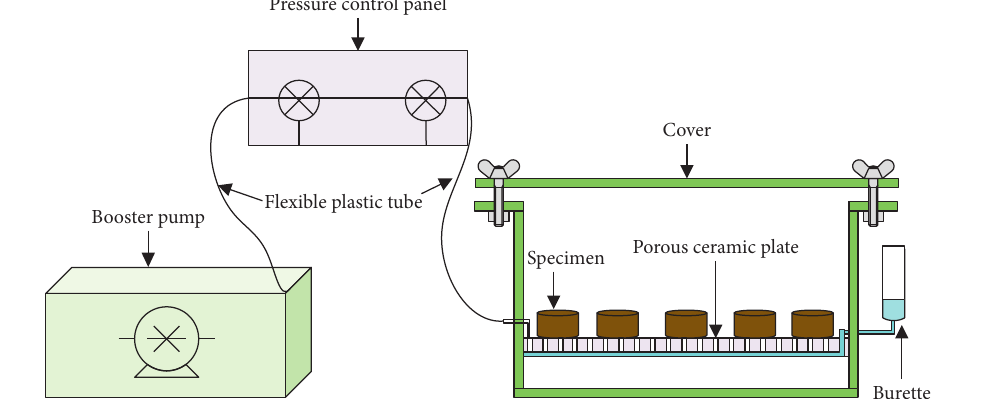
Figure 5: Pressure chamber test apparatus.